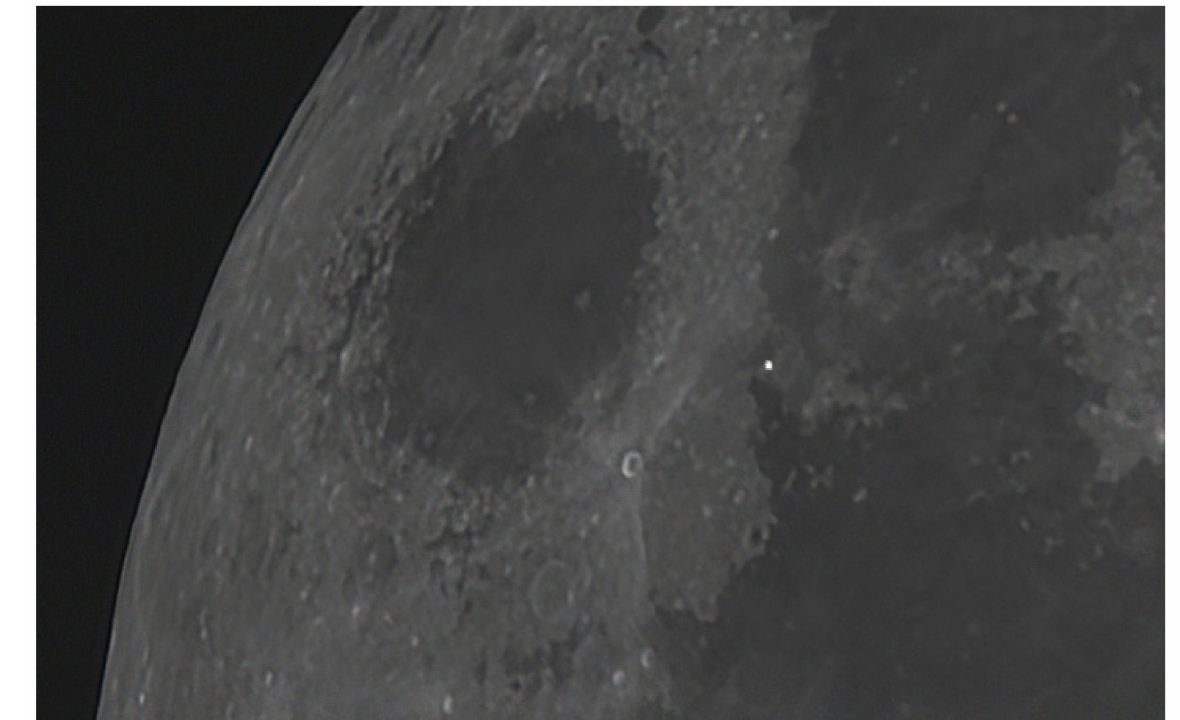
Figure 6. A single raw frame near the detection frame of Flash 1 ( left ). Stack of 100 video frames among the 150 that followed the last frame where Flash 1 was detected ( right ). Data from Macei ó .